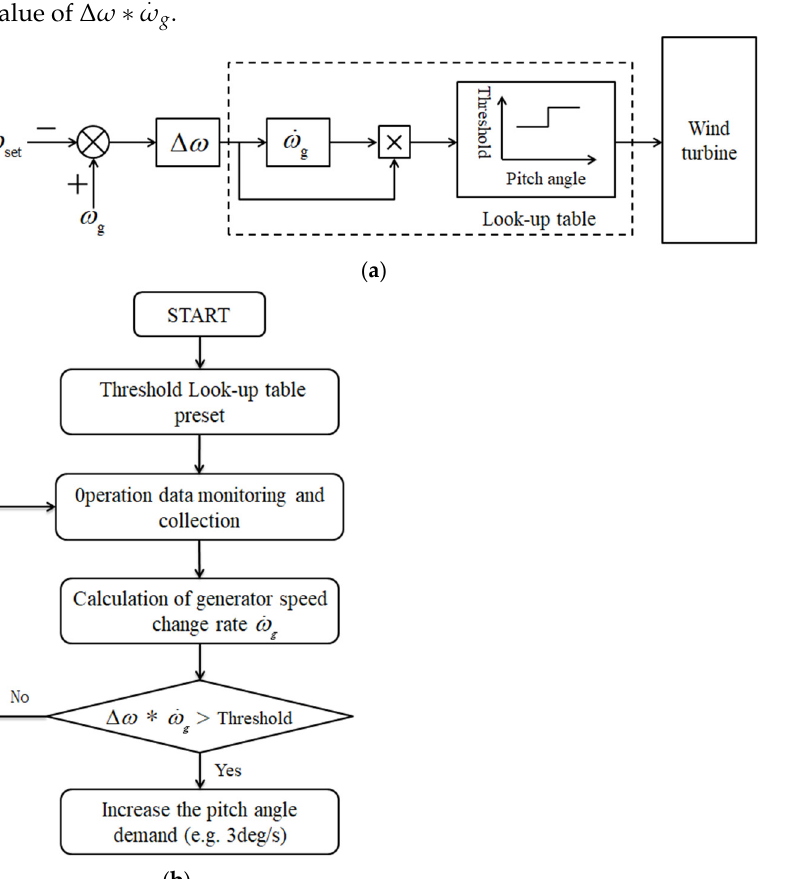
Table 1. Wind turbine information and simulation parameters.